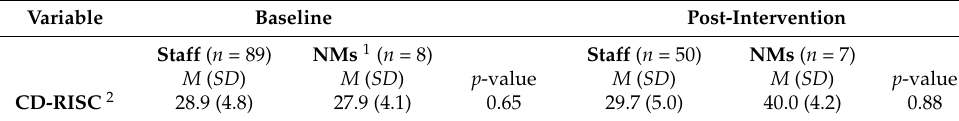
Table 6. Differences in Resilience Scores at Baseline and Post-intervention.